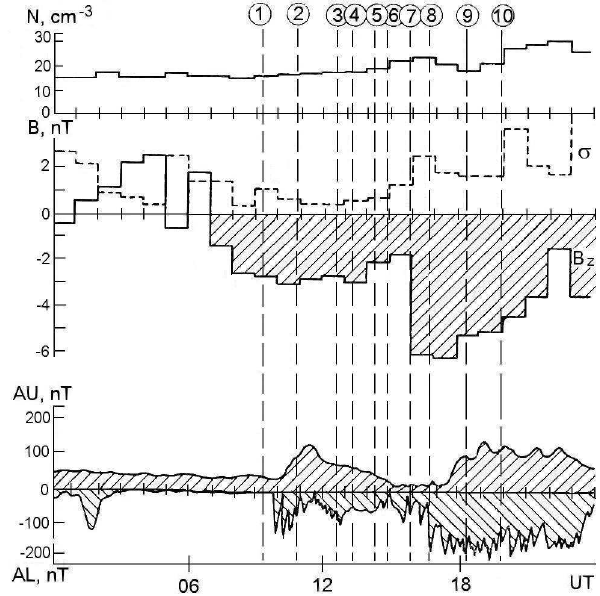
Figure 30. Solar wind plasma density and IMF parameters (two top panels) and variations of the AU and AL magnetic indices on December 03, 1973. Vertical dashed lines mark the moments of overflight of two DMSP satellites over the northern polar region (Sergeev and Vorobjev, 1979).